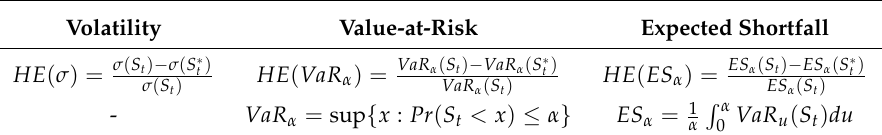
Table 16. Risk Reduction Measures.